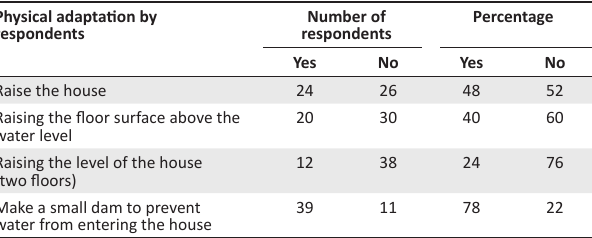
TABLE 3: Physical adaptations by